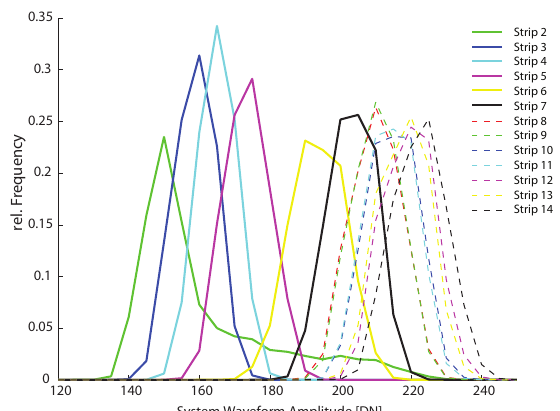
Figure 5: Histogram of the system waveform amplitudes ˆ S per flight strip of the 2005 campaign (bin size: 5 ).